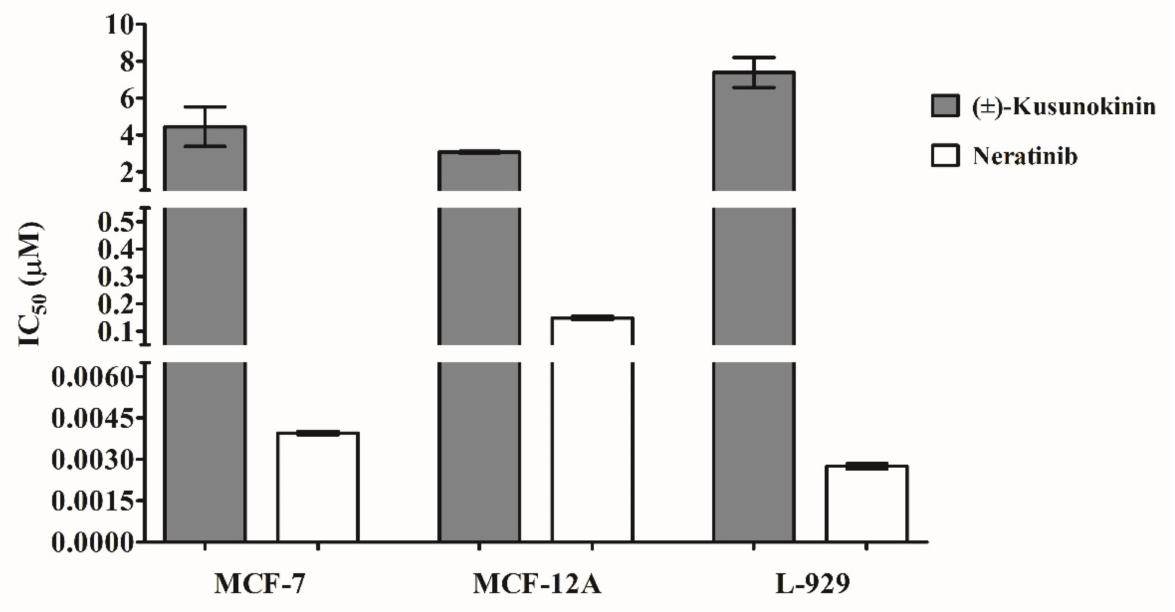
Figure 4. Cytotoxicity effect of synthetic ( ± )-kusunokinin and neratinib. Three different cell lines (MCF-7, MCF-12A and L-929) were incubated with tested compounds and incubated for 72 h. The cytotoxicity effects of each compound were determined using an MTT assay. Data represent the mean ± SD of three independent